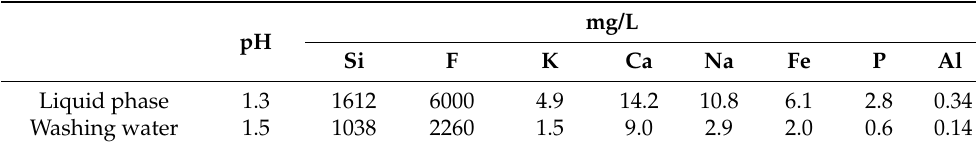
Table 2. Characterization of the Liquid Phase of the Sludge.